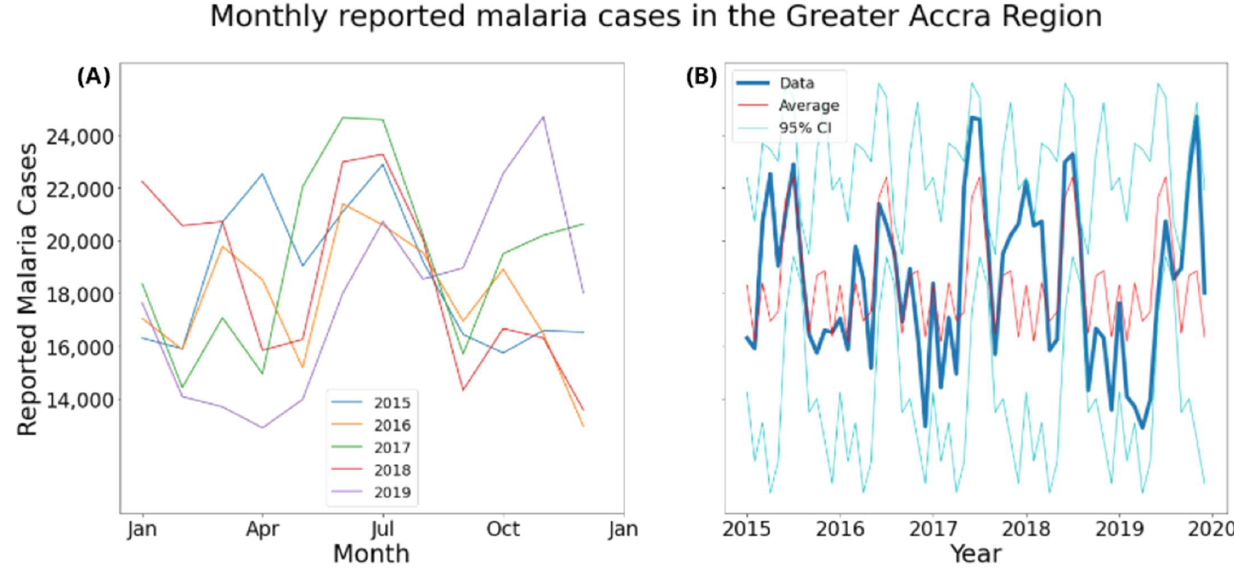
Figure 3. Line plot of monthly reported malaria cases with mean and 95% confidence interval in the Greater Accra Region, 2015–2019: ( A ) Each year in different colours; ( B ) Whole study period as one line.